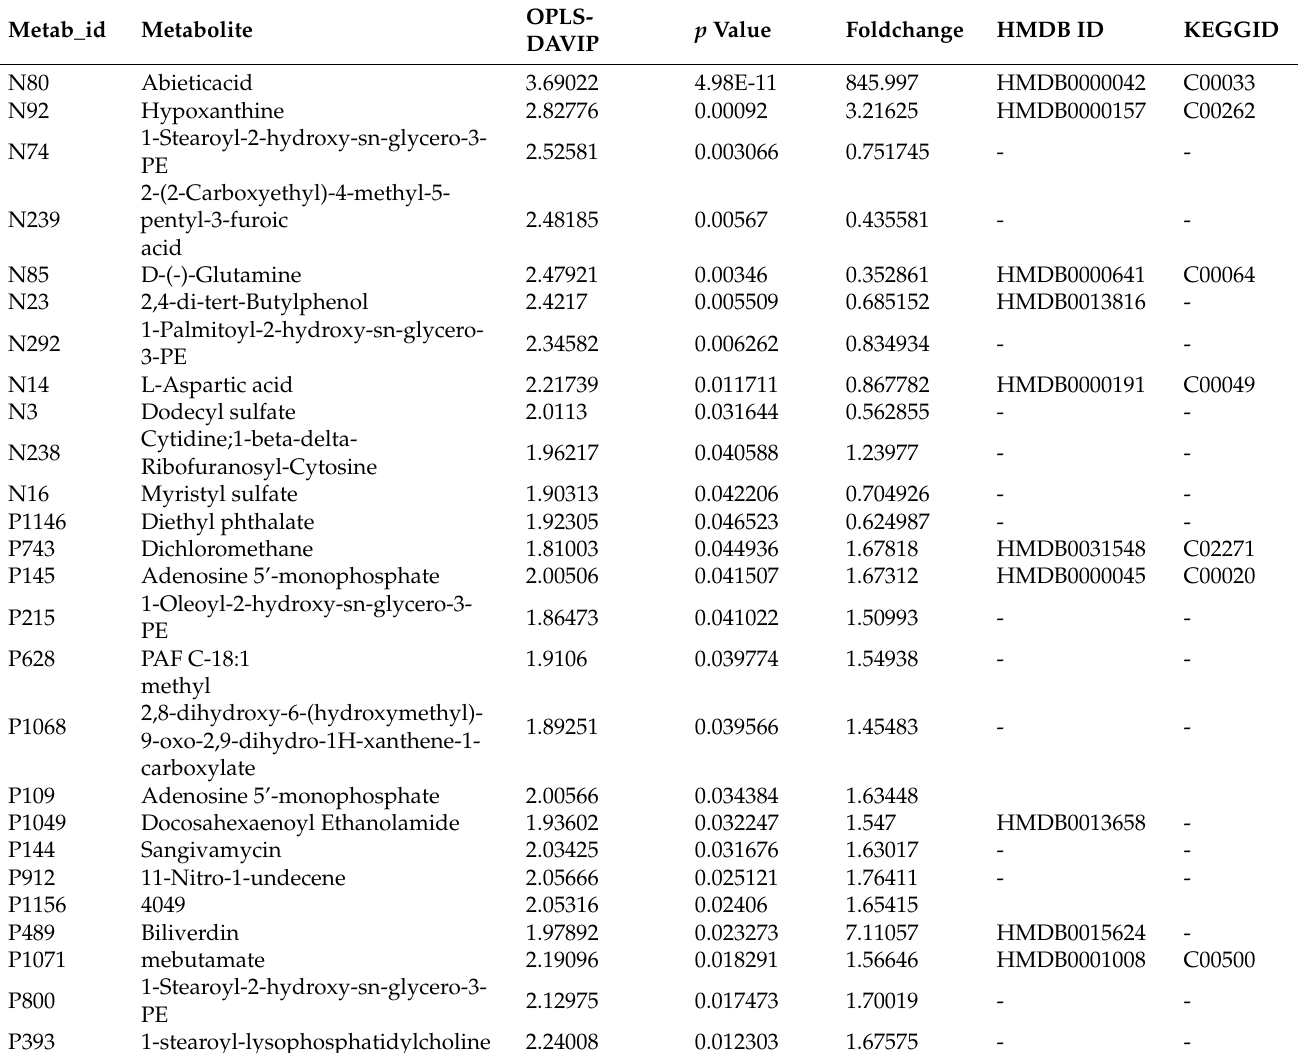
Table 2. The significantly altered metabolites in the hippocampus between the CCFM1025 and model